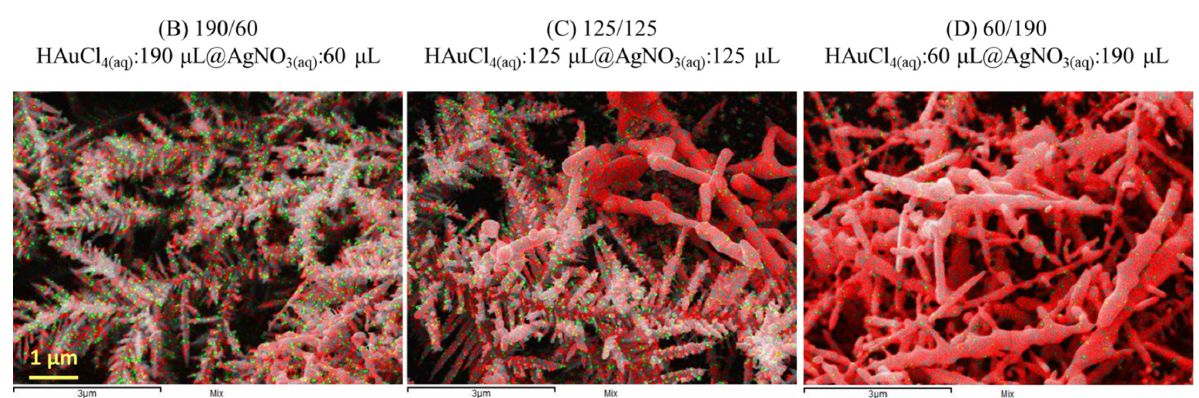
Figure 3. Top-view photo and SEM images of the Au@Ag-DNFs/Si with various Au/Ag ratios ( A – E ). The photo and SEM images presented the synthesized Au@Ag-DNFs on the Si substrate with Au/Ag ratios of ( A ) 250/0, ( B ) 190/60, ( C ) 125/125, ( D ) 60/190, and ( E ) 0/250. The bottom pictures are the zoom-in of the red-square marked area. EDX results revealed only Au and Ag signals of samples Figure 4 B–D. Au and Ag have the same crystal structure lattice constant. Therefore, Ag can be densely deposited on Au DNF cores with smooth surface coverage. The pseudo-colored EDX mapping images, with green and red indicating Au and Ag, exhibited a well-synthesized Au core and showed that the Ag shell DNF structure provided stabilized coverage.